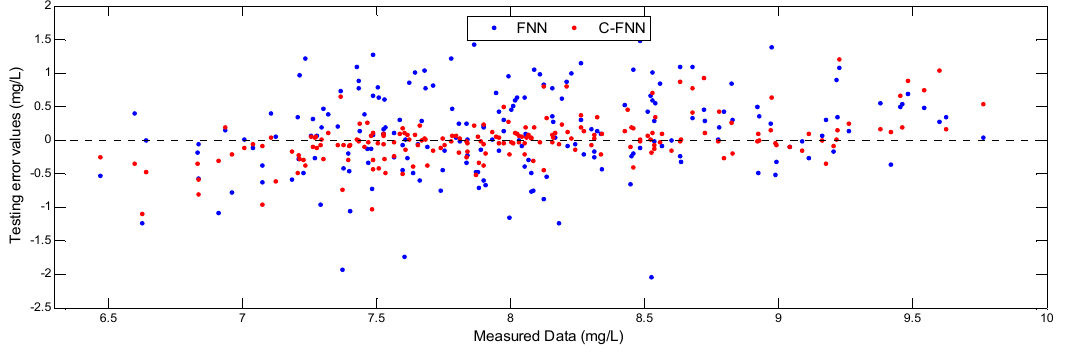
Figure 12. The training error of the FNN, C ‐ FNN for BOD. Water 2016 , 8 , 581